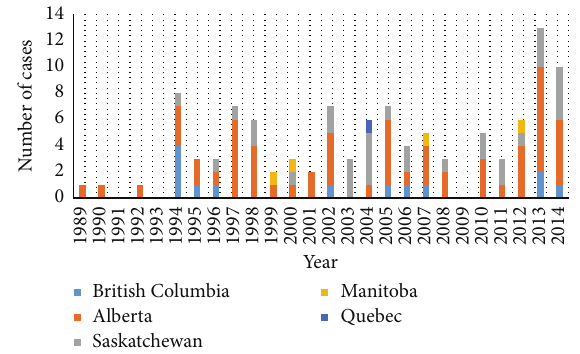
Figure 1: Number of Hantavirus cases in Canada from 1989 to 2014. Reproduced and adapted with permission from Drebot et